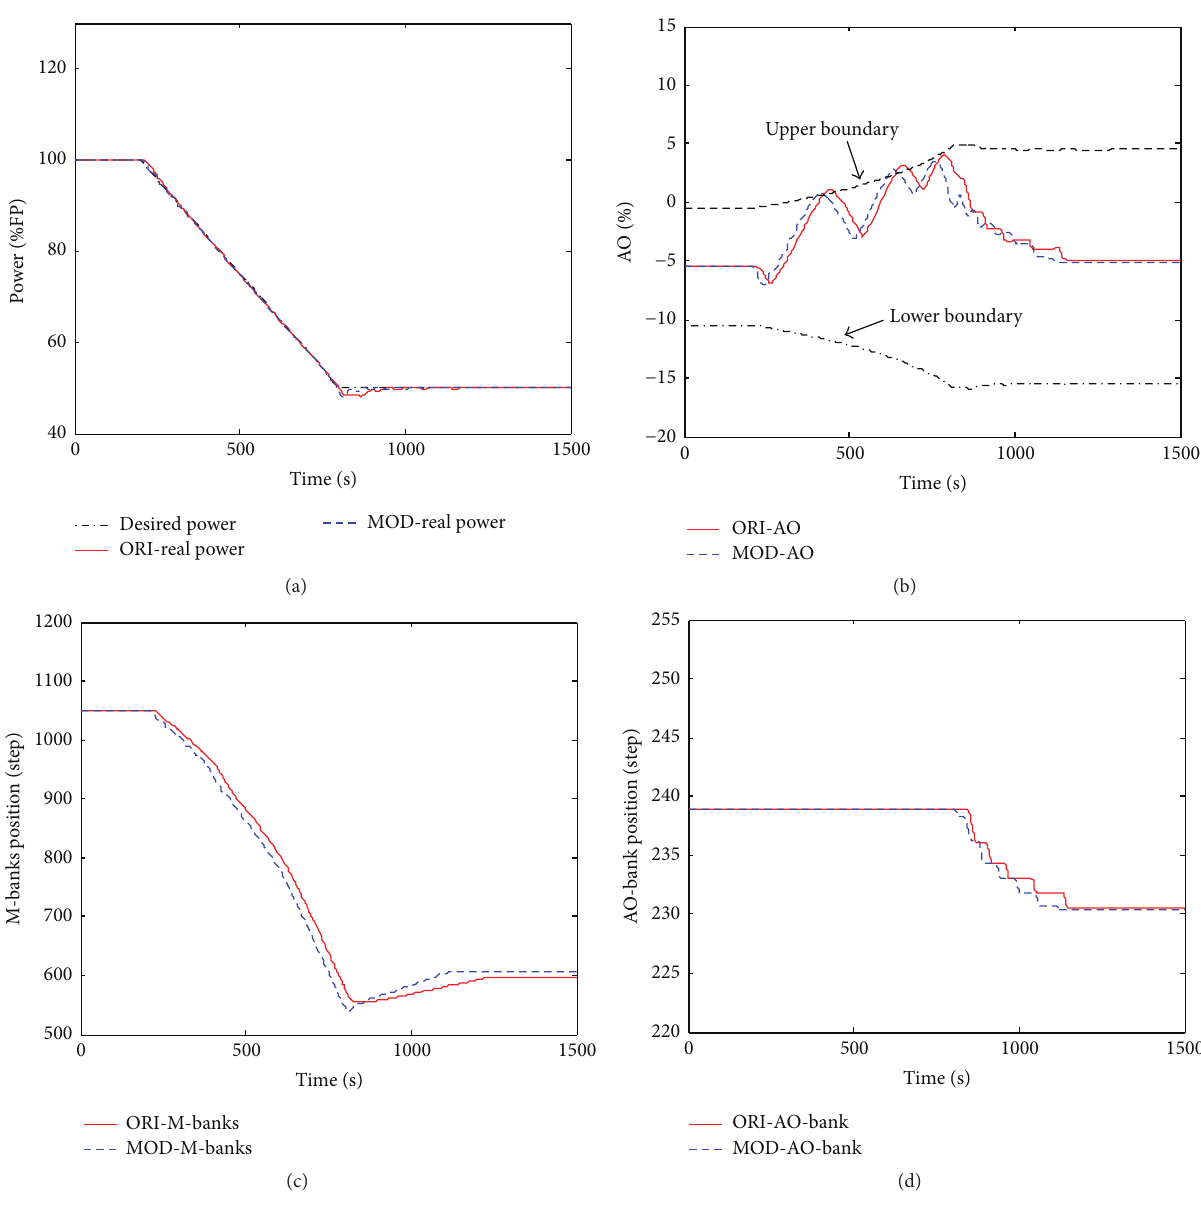
Figure 9: The 5% FP/min ramp load decrease simulation results obtained with the improved MSHIM control strategy: (a) desired and real nuclear powers (% FP), (b) AO (%), (c) M-bank position (Step), and (d) AO-bank position (Step) (the prefixes “ORI-” and “MOD-” denote the “original” and “modified,” resp.).